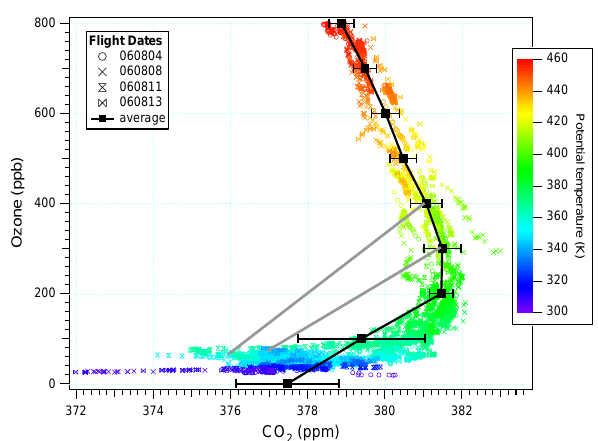
Fig. 5. Correlation between O 3 and CO 2 . The data are coloured to potential temperature. The black line represents the average CO 2 profile for all local flights. The grey lines are the possible mixing lines that are also displayed in Fig.